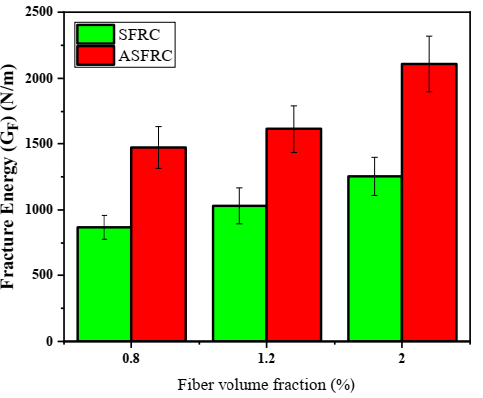
Figure 9. Average fracture energy of ASFRC and SFRC with respect to the steel fiber volume